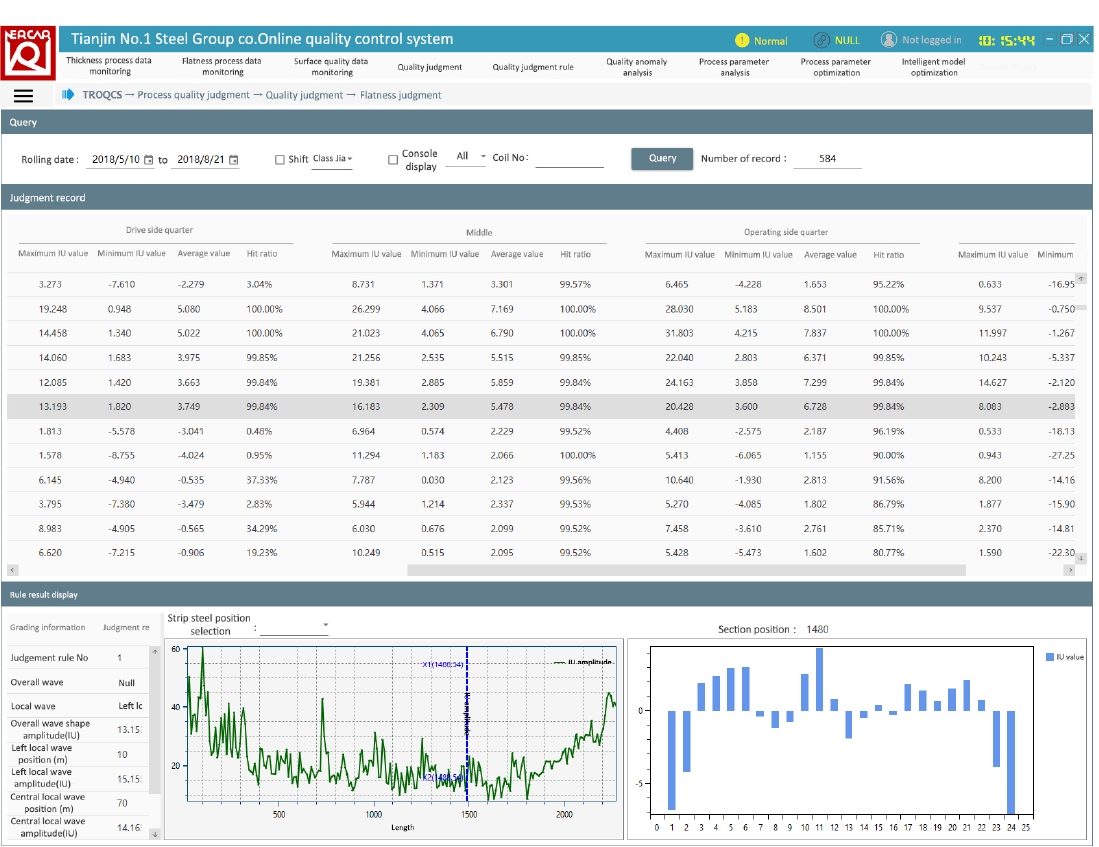
Figure 9. The interface of the flatness quality evaluation